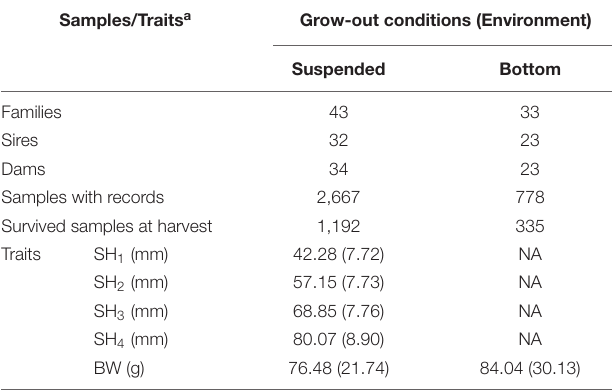
TABLE 1 | Summary statistics of families, sample number, and phenotypic values of traits in yesso scallops in the study. Samples/Traits a